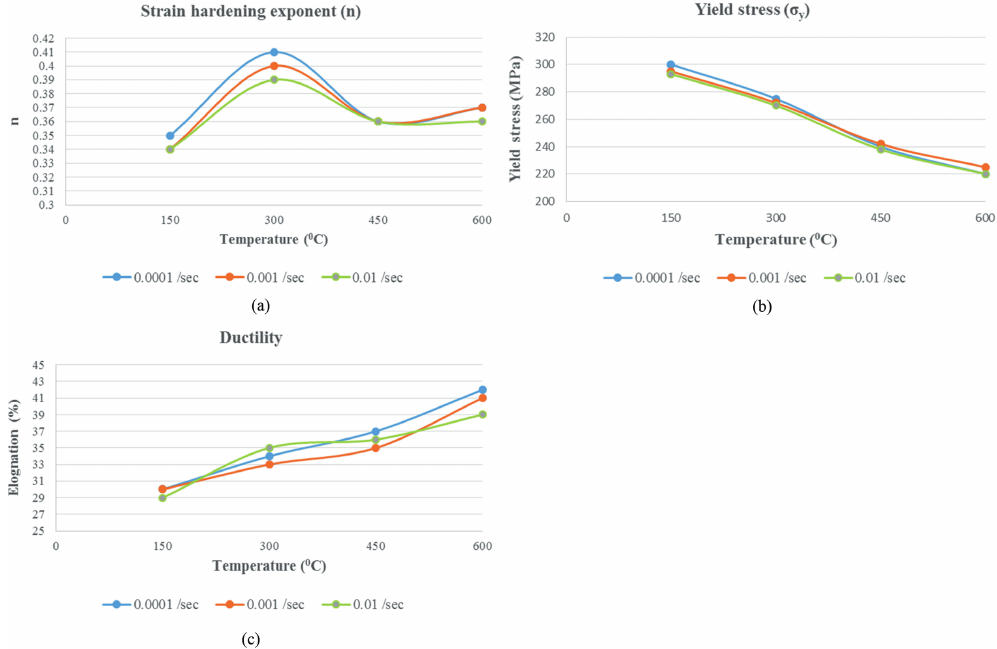
Figure 11: Variation of material properties of ASS 304 with respect to temperatures for different strain rates (a) Strain hardening exponent (b) Yield stress (c) % Elongation.